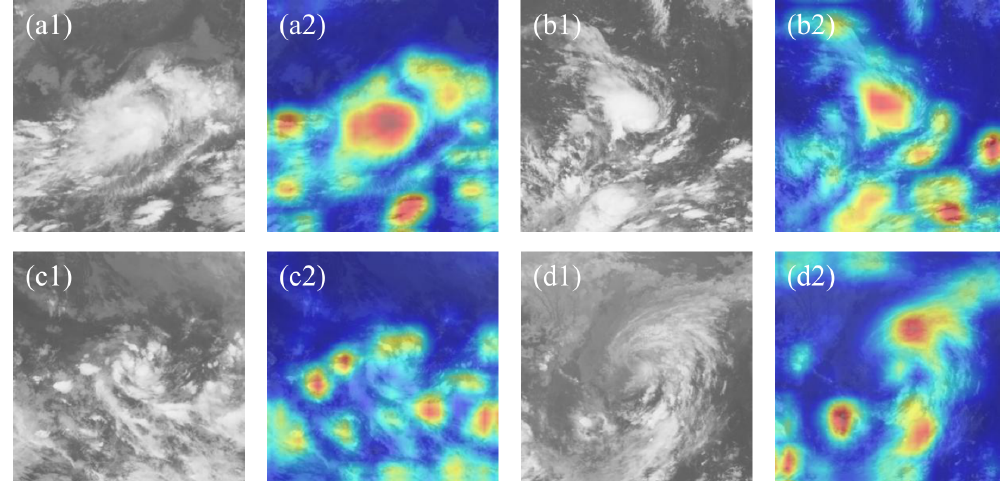
Figure 11. Heat maps of some non-TC images misjudged as TC images compared with associated L images.